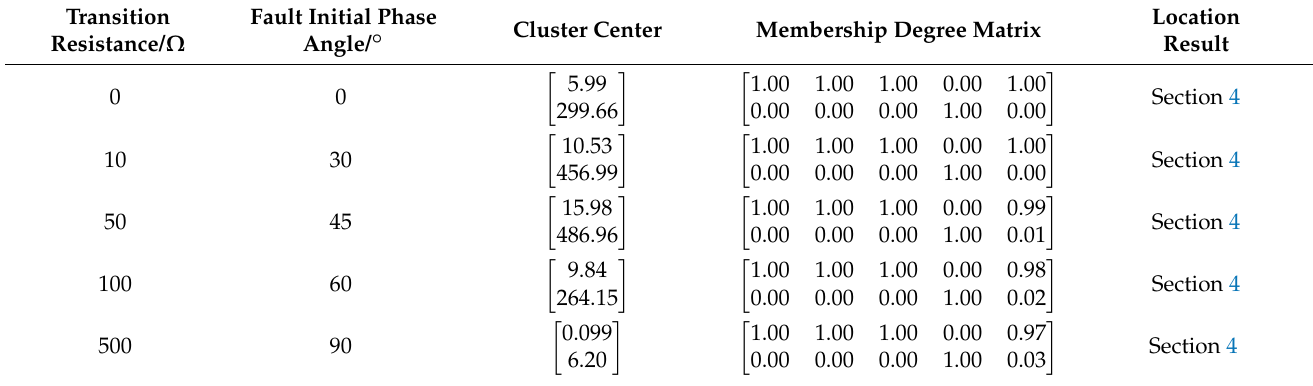
Table 6. Positioning results of distributed generation connected to distribution network.